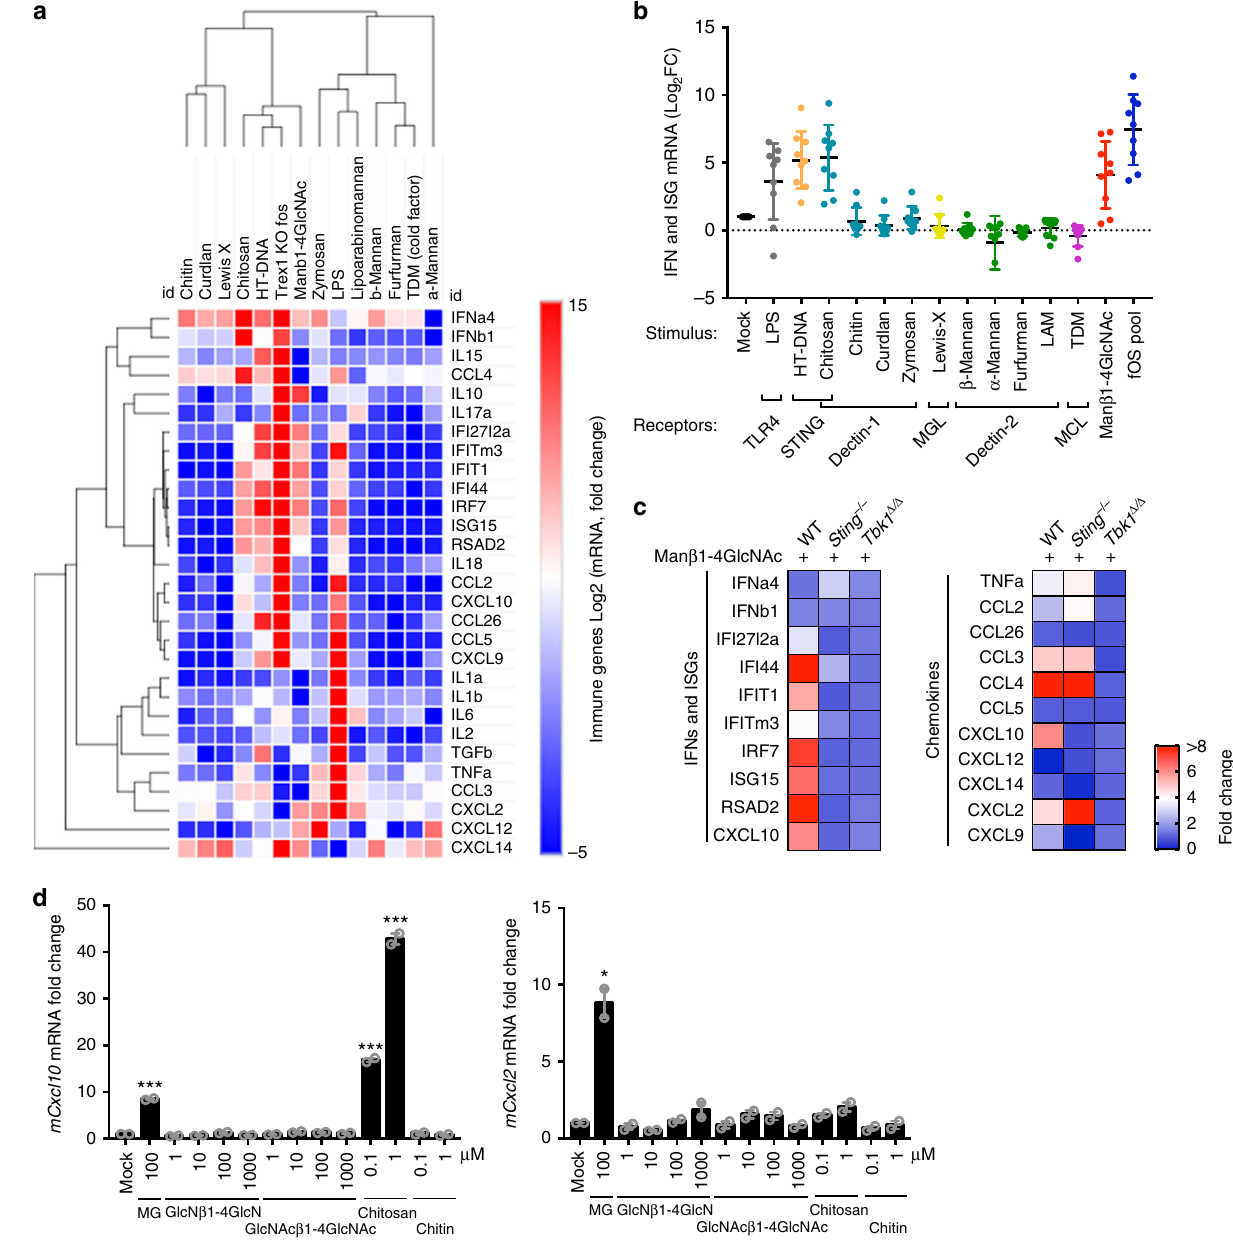
Fig. 6 The Man β 1-4GlcNAc disaccharide activates a broad immune gene signature that is similar to those acticated by DNA or chitosan. a Hierarchical heat map analysis of immune gene (as indicated on the right) expression in BMDMs treated with various ligands (as indicated on top) for 24 h. mRNA expression of each gene was measured by qRT-PCR. b IFN and ISGs immune gene expression in BMDMs treated with various ligands (as indicated on bottom). Same gene expression data set as in a . Each dot represents one gene. c A heat map of immune gene expression in WT, Tbk1 Δ / Δ and Sting − / − BMDMs stimulated with Man β 1-4GlcNAc disaccharide for 24 h. mRNA expression of each gene was measured by qRT-PCR. d Quantitative RT-PCR analysis of mCxcl10 and mCxcl2 mRNA in BMDMs that were treated with mock or indicated glycans (bottom) for 24 h. mRNA expression of each gene was measured by qRT-PCR. Data are from a representative set of at least two independent experiments. Error bars indicate SEM. Unpaired t